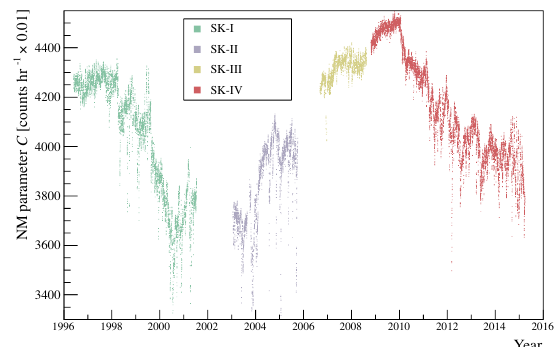
Figure 8. The neutron monitor parameter, C , over the Super- K operational period, where low values of C correspond to high solar activity, showing that almost two solar cycles are covered by the Super-K data